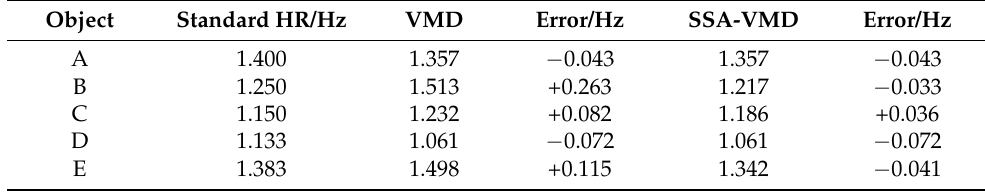
Table 3. Experimental comparison results at 0.6 m.